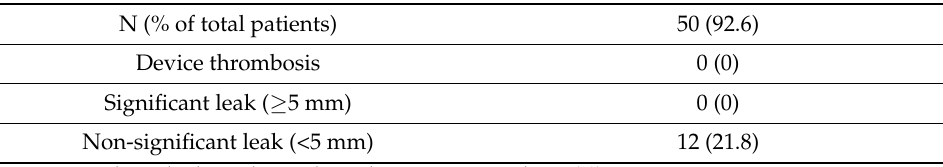
Table 4. TEE follow-up 1 month after LAAC ( n =